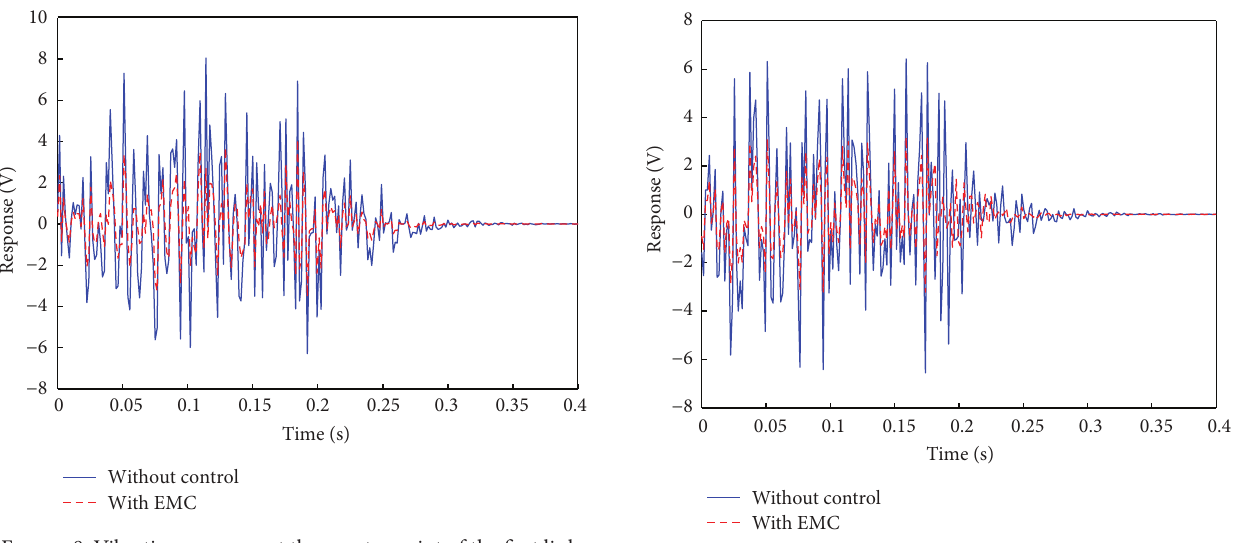
the first mode of the first link are calculated as 𝑘 11 𝑝 = 118.7 and 𝑘 11 = 24.3 , and the ratio for the second mode is optimized as 𝑑 : 𝑘 12 = 𝑘 11 : 𝑘 12 = 1 : 0.259 . The response voltages 𝑘 11 𝑝 𝑝 𝑑 𝑑